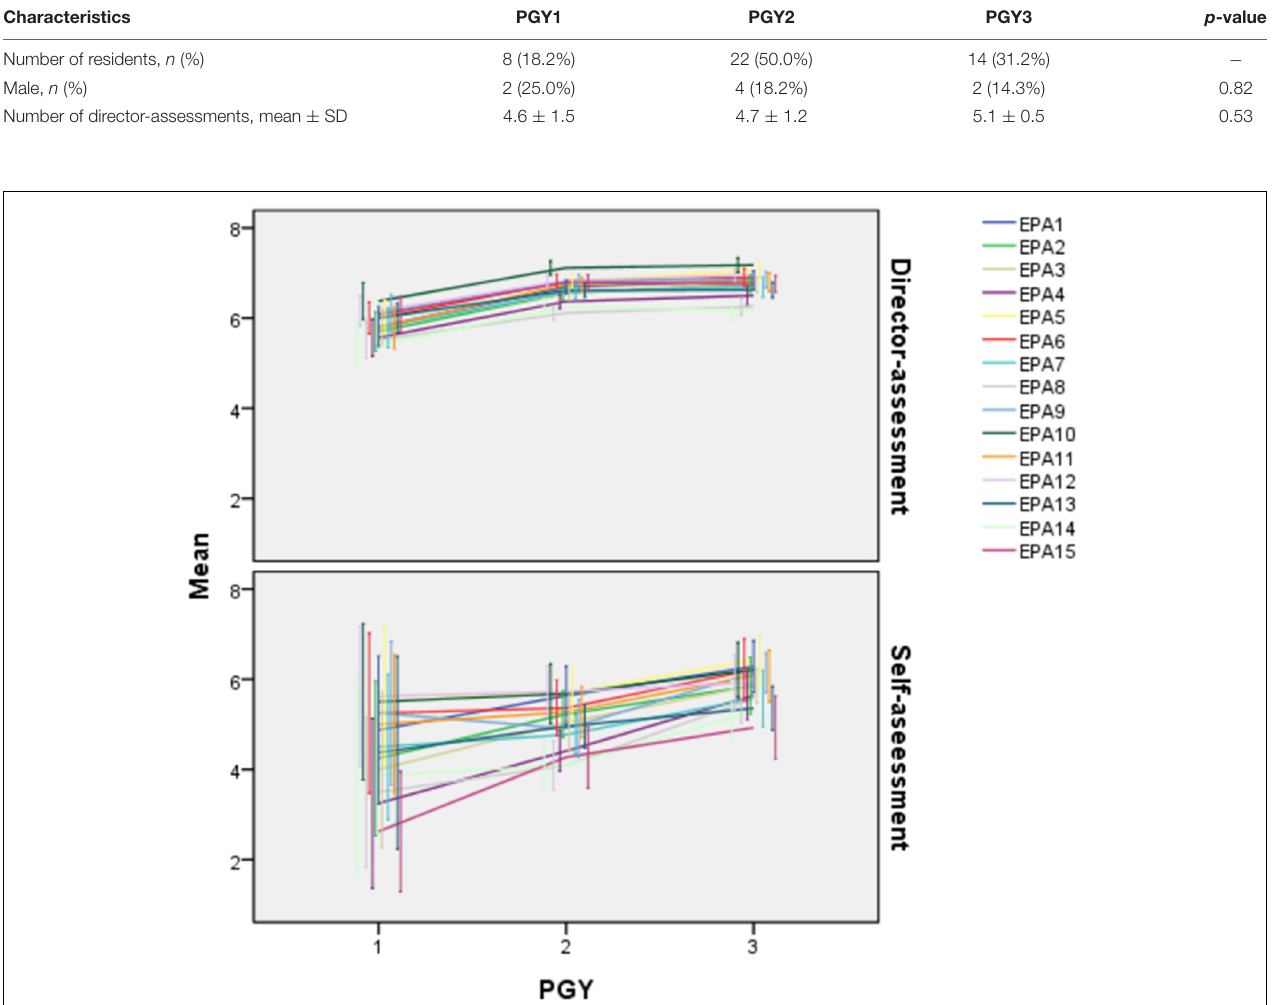
Frontiers in Pediatrics |